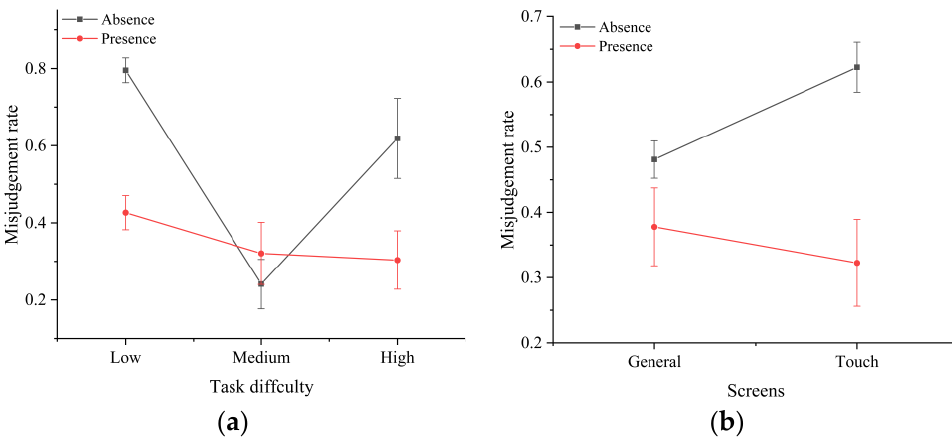
Figure 8. Effect of time pressure on undetected errors.